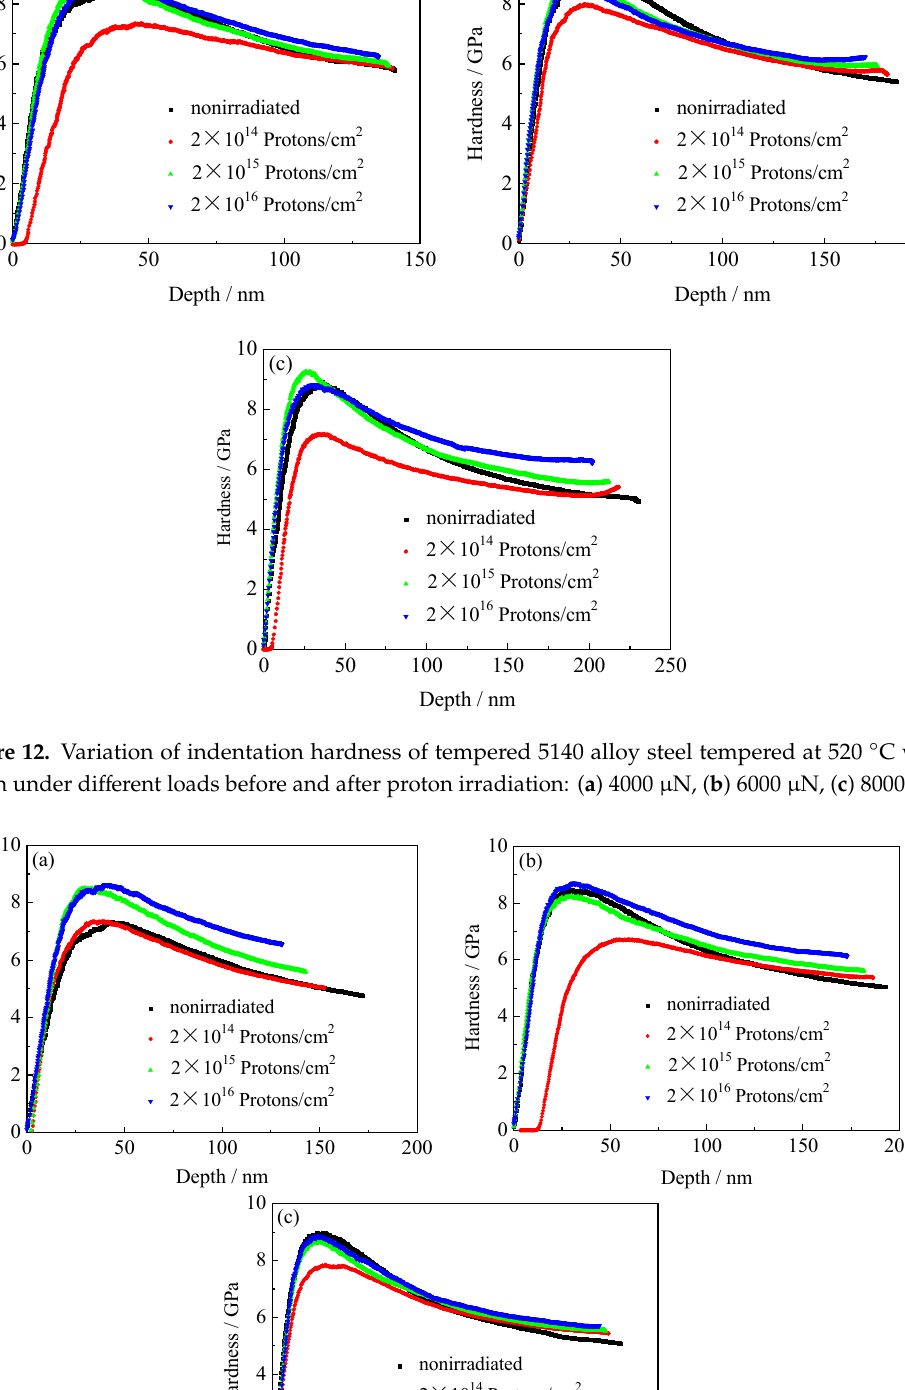
Figure 11. Variation of indentation hardness of tempered 5140 alloy steel tempered at 480 °C with depth under different loads before and after proton irradiation: ( a ) 4000 µN, ( b ) 6000 µN, ( c ) 8000 µN.